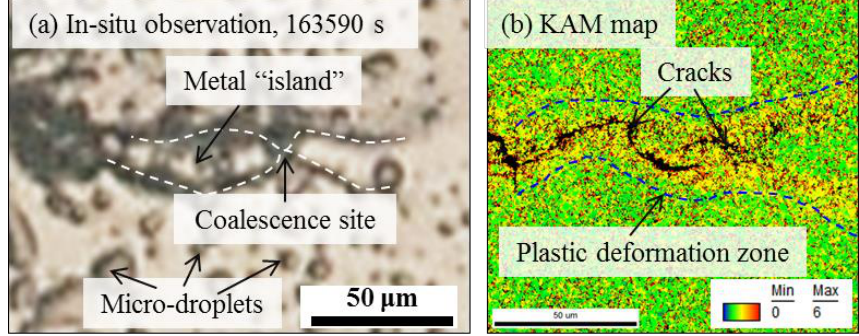
Figure 15. ( a ) In-situ observation of one coalescence event at the advancing crack tip; ( b ) KAM map of the corresponding area calculated using third nearest-neighbor EBSD points and a maximum of 6 ◦ showing the localized plastic deformation zone. Online version in